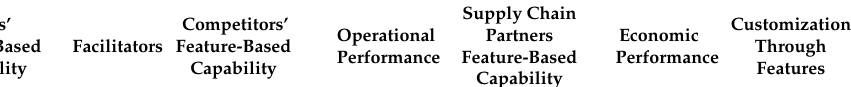
Table 2. Explorative factor